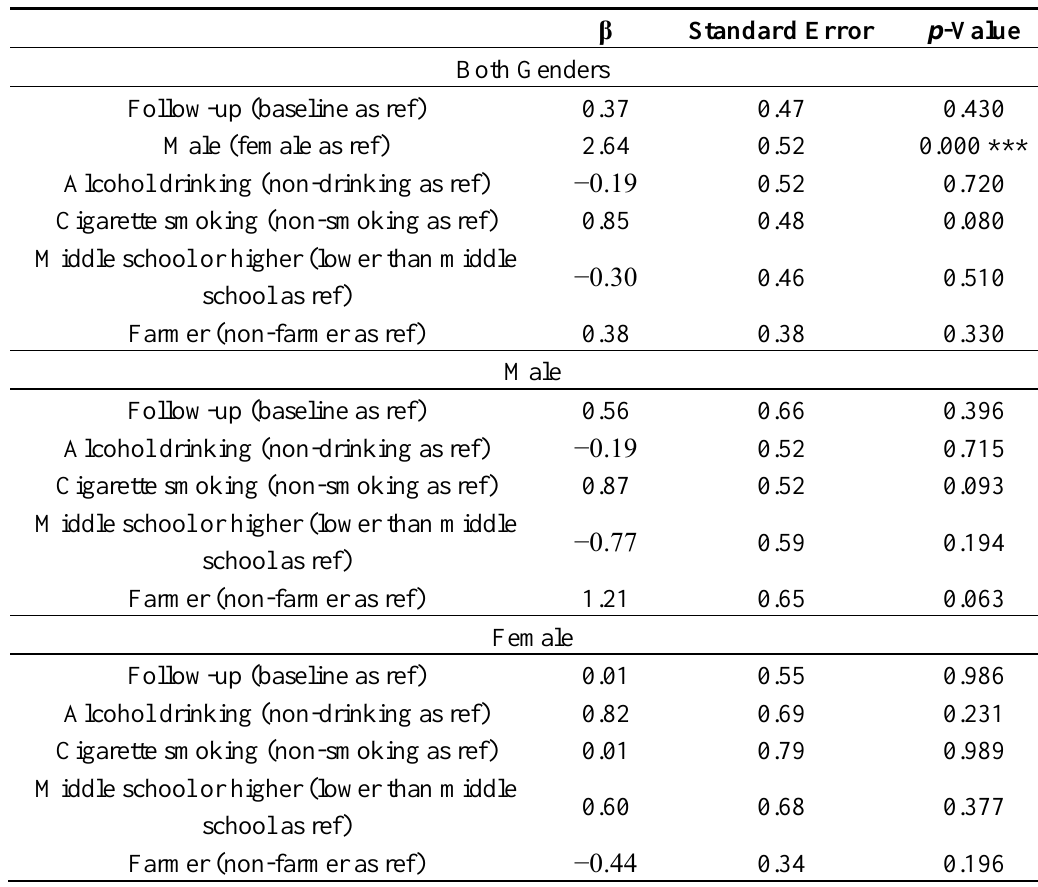
Table 2. Gender-specific correlates of homocysteine levels for participants over age 21 ( n = 972) †